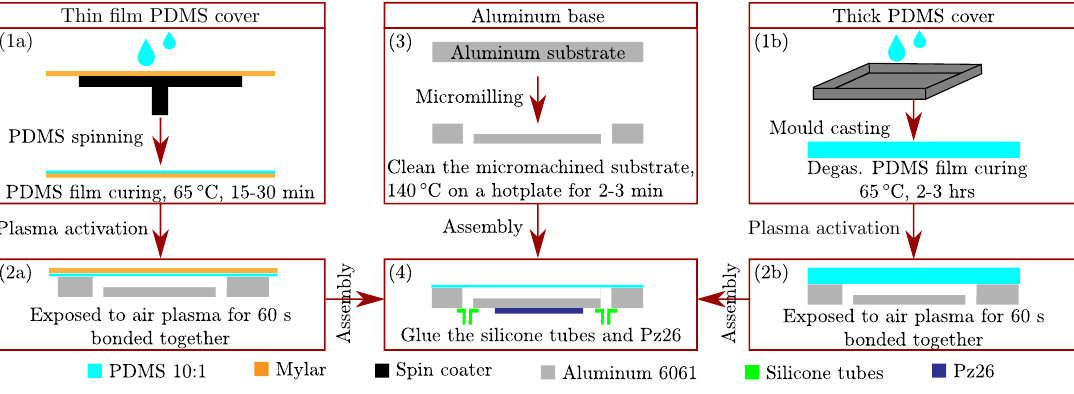
Figure 2. Schematic showing the sequence in the fabrication of the aluminum devices with PDMS covers. Production of a thin PDMS cover on a Mylar sheet by ( 1a ) spinning and curing followed by ( 2a ) bonding to the aluminum base by plasma activation and removal of the Mylar sheet. ( 1b ) Production of a thick PDMS cover by mould casting followed by ( 2b ) bonding to the aluminum base by plasma activation. ( 3 ) Fabrication of the channel in the aluminum base by micromilling. ( 4 ) Attachment of silicone tubes and the Pz26